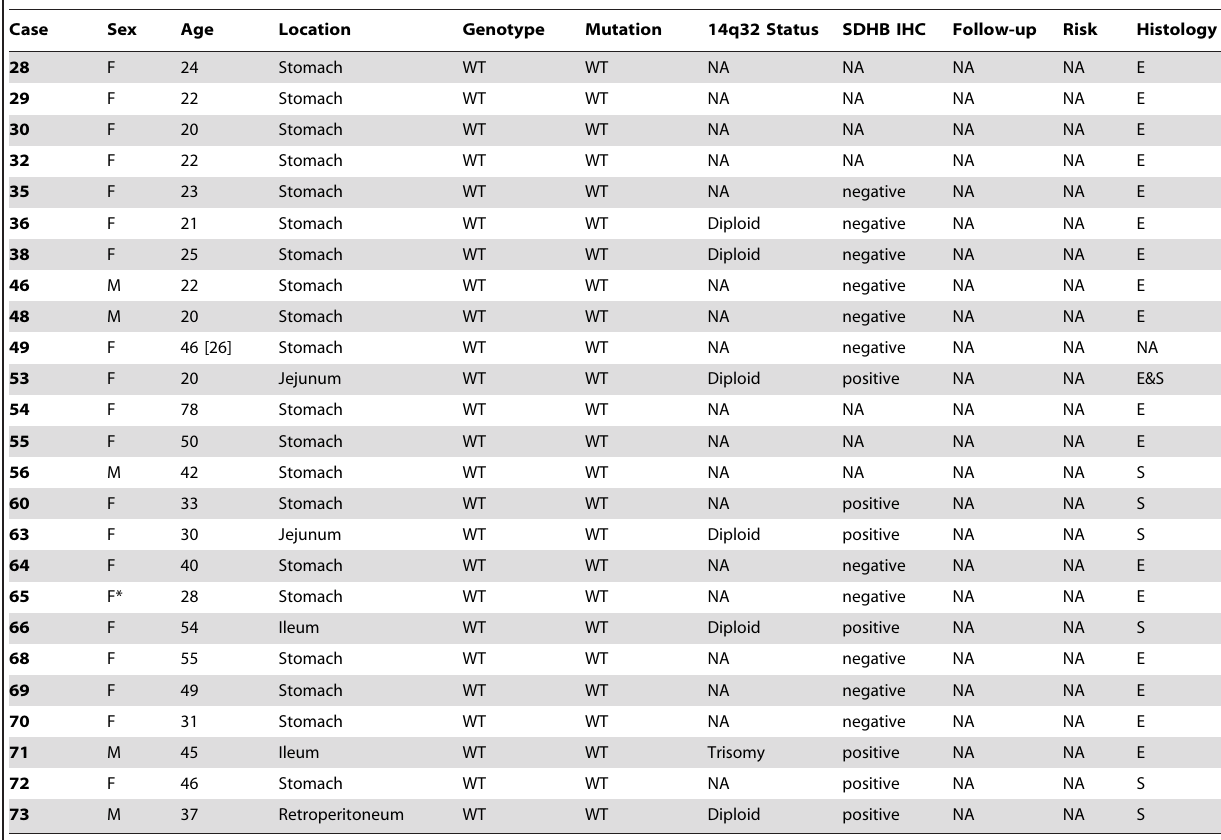
Table 2. Adult WT case